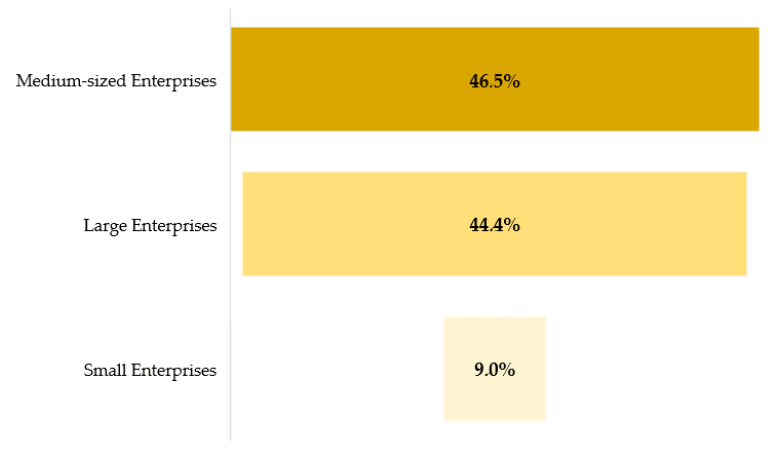
Figure 2. Data file structure by enterprise category. Source: Author ’ s own.